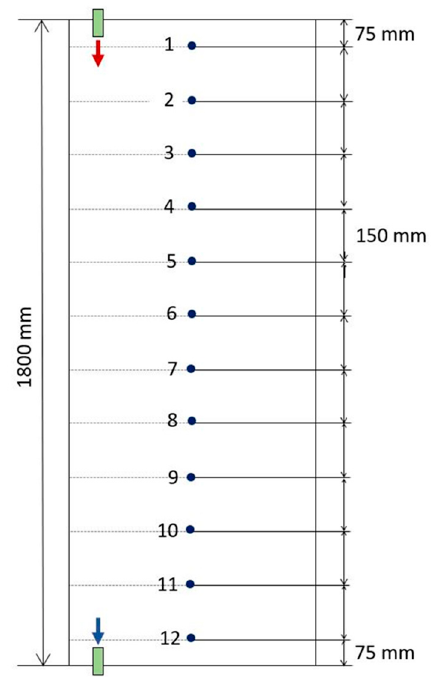
Figure 5. Schematic representation of the experimental tank for the charge phase [9]. The hot water inlet (red arrow) and the cold-water outlet (blue arrow) are placed at the top and the bottom of the tank, respectively.